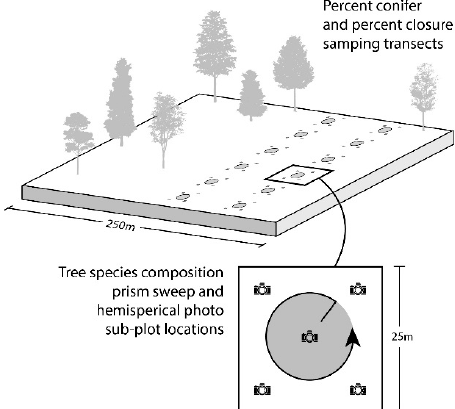
Figure 4. Example observation plot sample transects of tree species composition prism sweep sites (percent confer) and hemispherical photography locations (percent closure).